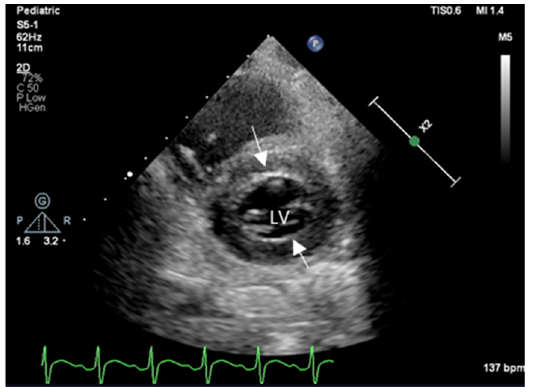
Figure 1. Two-Dimensional echocardiography shows a short axis of LV with increased wall thickness due to edema and inflammation immediately after heart transplantation; arrows point to thickened interventricular sept, and LV posterior wall thickness increased (z score + 2).